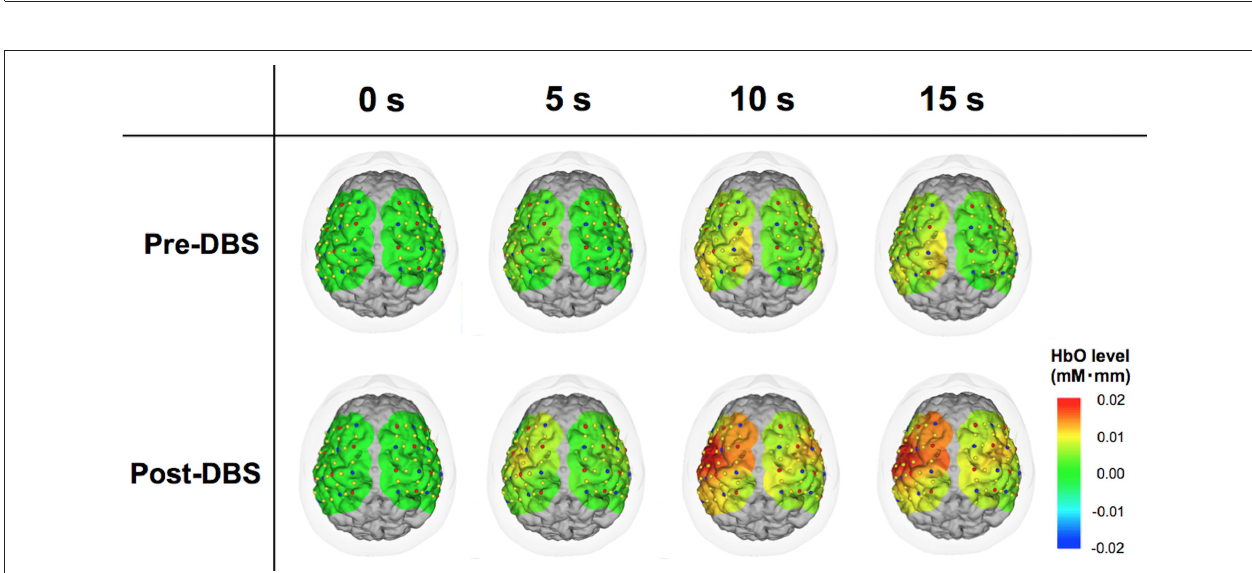
FIGURE 2 | Comparison between pre- and post-deep brain stimulation (DBS) cortical activity in a representative case. The color map representing cortical activity superimposed onto the three-dimensional brain model was produced from the patient’s T1-weighted magnetic resonance imaging (MRI) image. Red and blue dots indicate the light sources and detectors, respectively. Yellow dots are channels formed by the combinations of the light sources and receivers. These images demonstrate the dynamic oxy-hemoglobin (HbO) response to motor task at 0, 5, 10 and 15 s. At 0 s, the levels of the measured areas were all corrected to zero. Cortical activity in the wide areas of operated-upon hemisphere increased following DBS